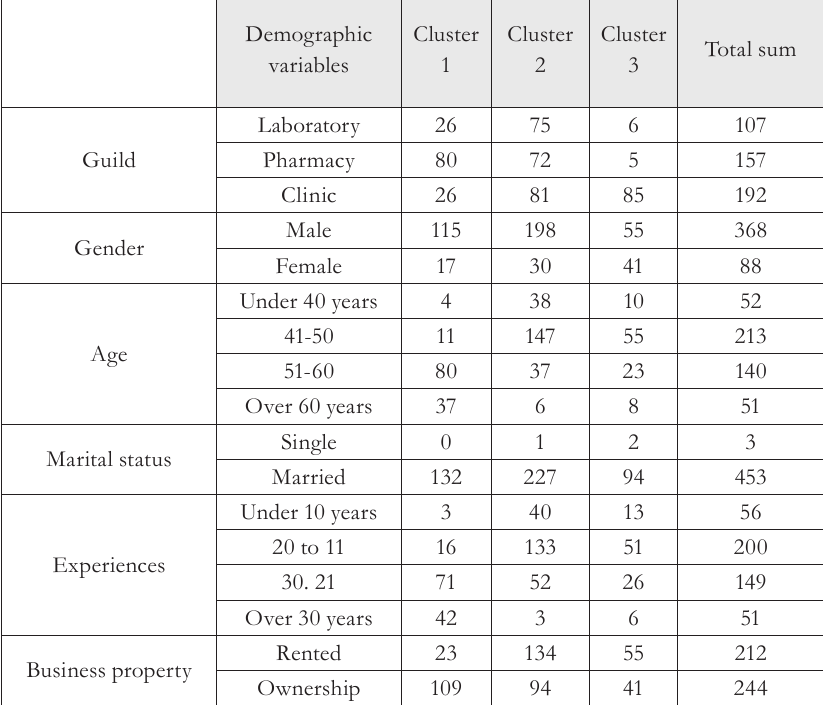
Tab. 5 - Demographic profile of clusters (Source: